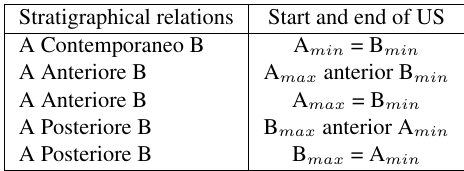
Table 2. Harris relations seen from an interval point of view.